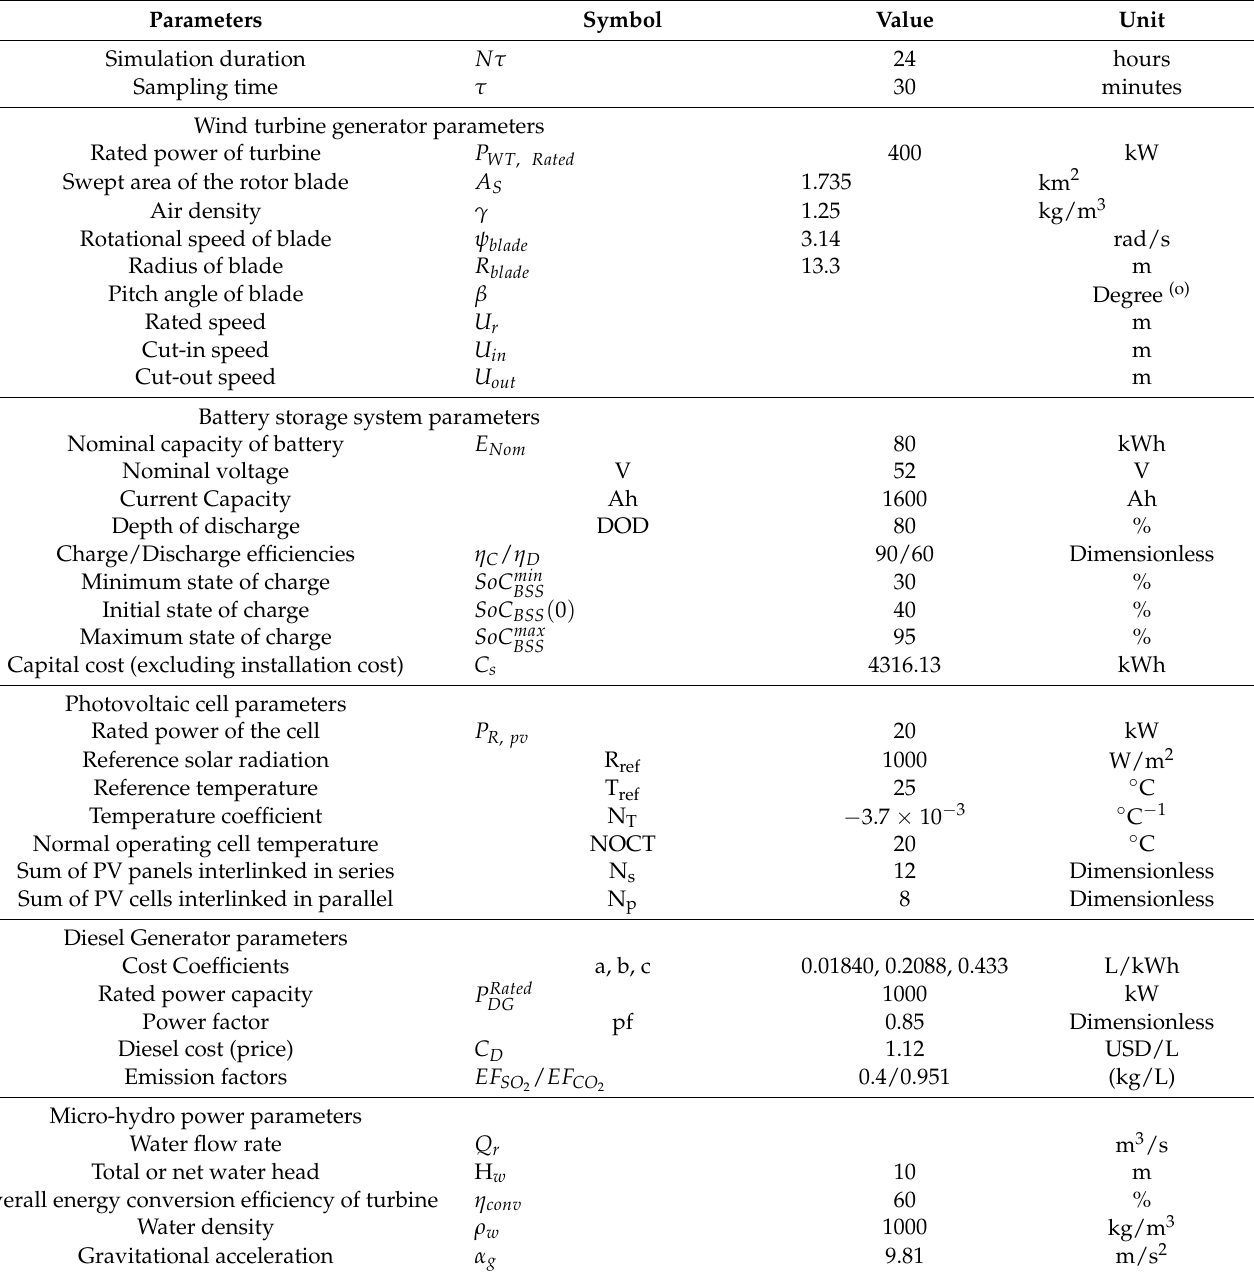
Table 1. Simulation technical